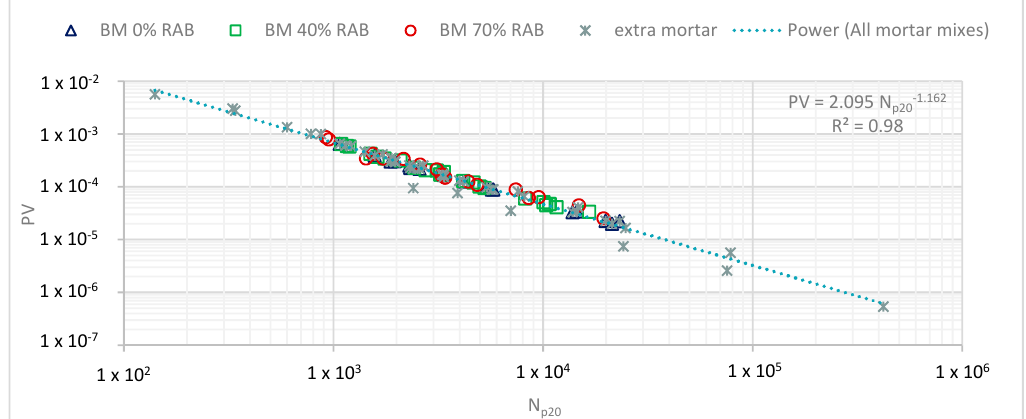
Figure 12. Fatigue resistance of the mortars for the three replacement rates of 0%, 40%, and 70% RAB based on the RDEC approach: Np20 vs. PV. The extra mortar points were derived from a previous study [23].